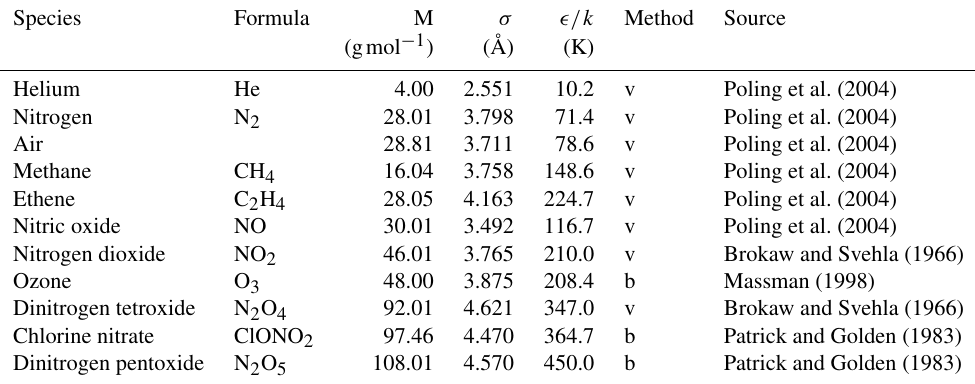
Table 1. Lennard–Jones parameters of the species investigated in this